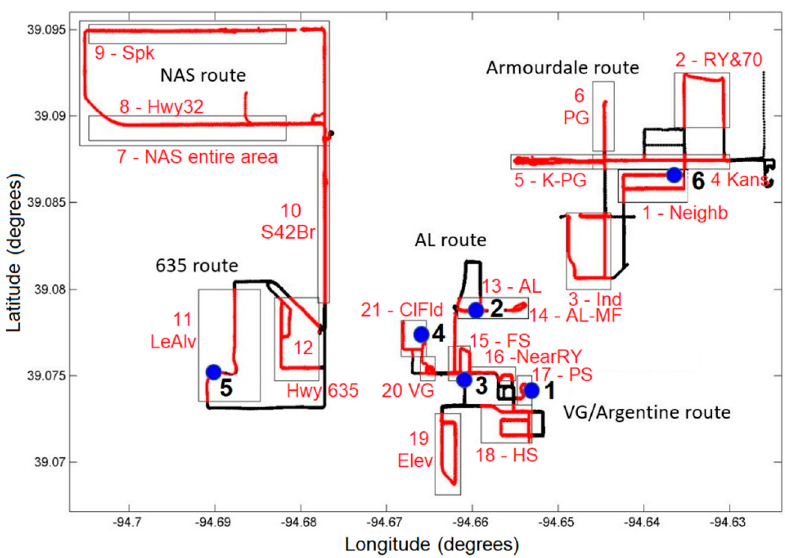
Figure 3. Schematic map of the study area showing mobile monitoring routes and selected sampling areas.